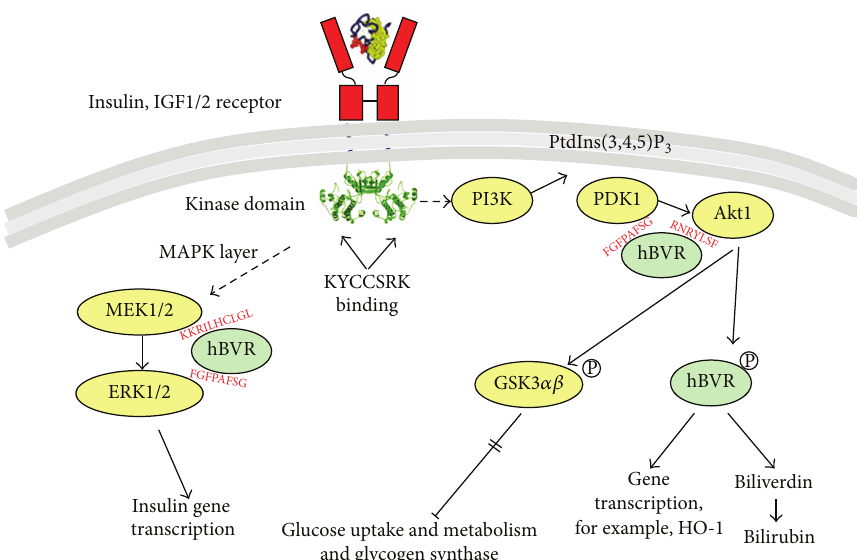
Figure 7: P2-dependent activation of the IRK/PI3K/Akt pathway. IRK activates both MEK/MAPK and PI3K/Akt pathways. On one side, activated PI3K [13, 14] generates PtdIns (3,4, 5) P 3 , which interacts with the PH domain of Akt and recruits the inactive protein to the membrane, where it is phosphorylated at T 308 by the 3-phosphoinositide-dependent kinase, PDK1 [15]. On the other side, BVR interacts with MEK1/2 and ERK1/2 to enhance activation of ERKs [16]. Activation of ERK1/2 results in activation of transcription factors to stimulate expression of the insulin gene [17]. The peptide, P2 (KYCCSRK), binds to the receptor kinase domain, which results in activation of the multistep process leading to activation of MEK1/2 in the MAPK pathway. Specific sequence motifs in hBVR mediate its interactions with proteins in the signaling pathways, where it acts as a scaffold to bring kinases in contact with their substrates [16]. Akts phosphorylate GSK 3𝛼, 𝛽 resulting in its inactivation; the inactive GSK3s in turn cannot phosphorylate and inactivate glycogen synthase, resulting in an activation of glucose